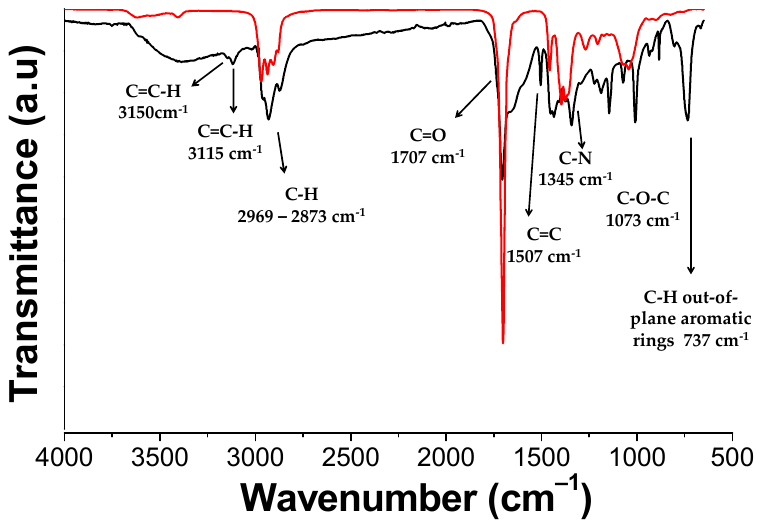
Figure 4. FT-IR spectrum of the pristine polymer (PK, red line) and of the polyketone modified with furfurylamine (PKFU, black line).